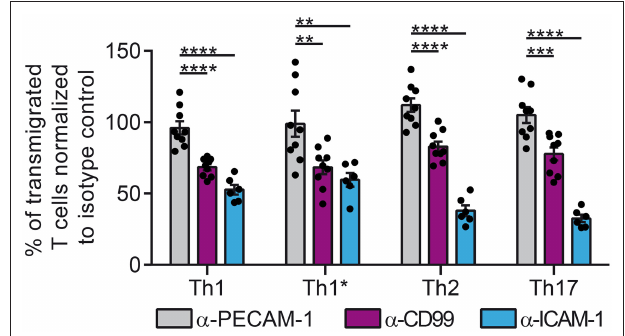
FIGURE 2 | PECAM-1 is not required for the diapedesis of human effector/memory CD4 + T cells across BLECs. Diapedesis of human CD4 + T-cell subsets (Th1, Th1*, Th2, and Th17) across the TNF- α -(1ng/ml) + IFN- γ -stimulated (20 IU/ml) human in vitro BBB model (BLECs) is shown. Prior to addition of T cells, BLECs were pre-treated with anti-human PECAM-1, anti-human CD99 or anti-human ICAM-1 blocking antibodies or the adequate isotype control antibodies. T cells were allowed to migrate for 8h across the BLEC monolayers. Transmigration rates are expressed relative to isotype control-treated filter inserts (100%). Data are derived from three independent experiments each performed in triplicates, except for ICAM-1 blocking conditions, which were done in two independent experiments each performed in triplicates. T cells were derived from 3 different healthy donors. Dots represent individual data points; error bar ± SEM. Reported statistics result from one-way ANOVAs with Dunnett’s multiple comparisons tests. ** p < 0.01; *** p < 0.001; **** p <